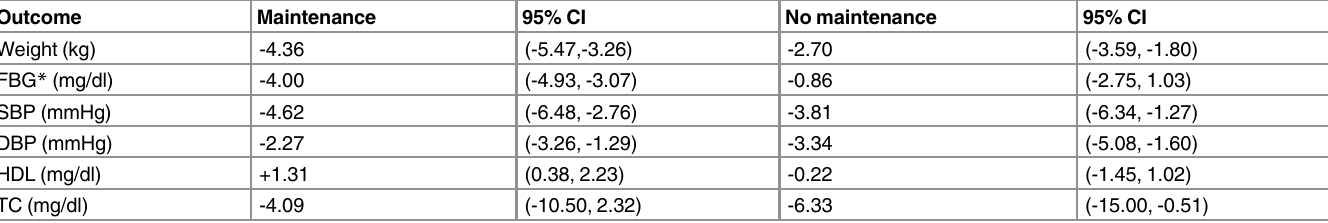
Table 3. Outcomes stratified by the presence of maintenance. (Supporting forest plot in S9 Fig.) Outcome Maintenance